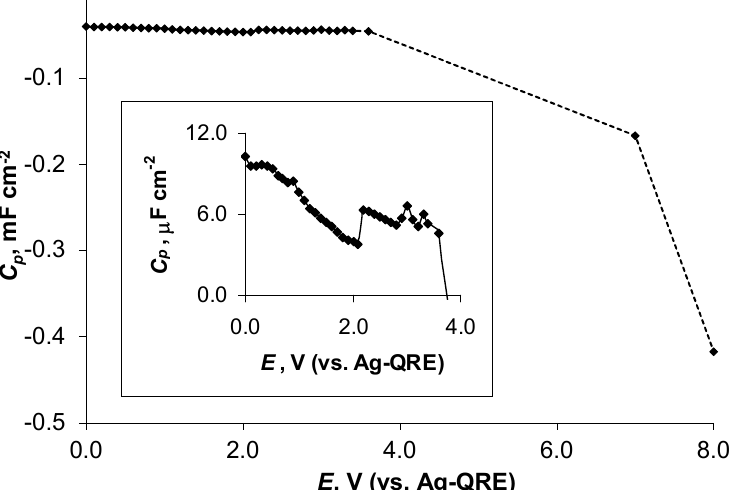
Figure 7. Parallel capacitance ( C p ) vs. Al-electrode potential ( E ) relationship at the electrochemical- impedance-spectroscopy modulation frequency 0.10 Hz.